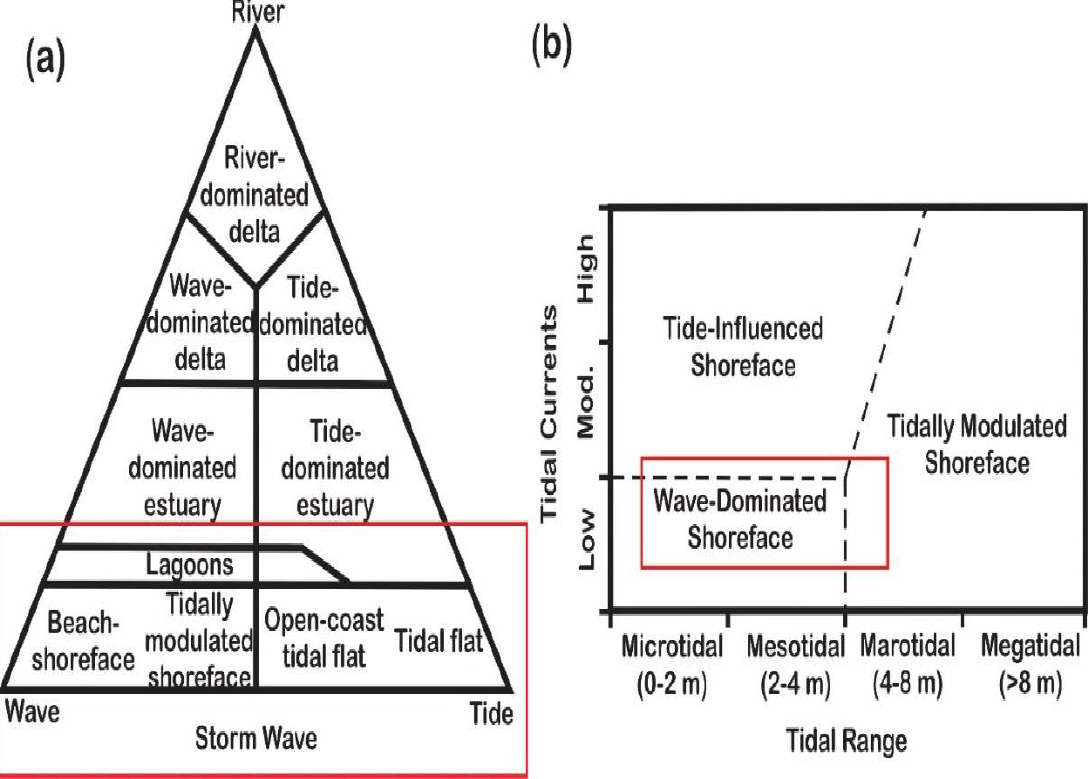
Figure 3: (a) Ternary diagram modified after Dalrymple et al. (1992) and Dashtgard et al. (2009) is used to relate the evidence of wave-tides dominated area of Lambir Formation. (b) The wave-dominated area is estimated to have tidal range from 0-2 m to 2-4 m which classified as micro- to meso-tidal range process (Johnson and Baldwin,